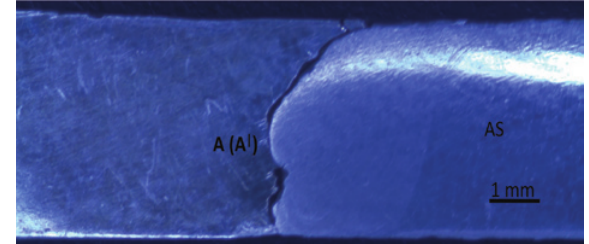
Figure 14: Tensile Fractured Sample after the tensile test.